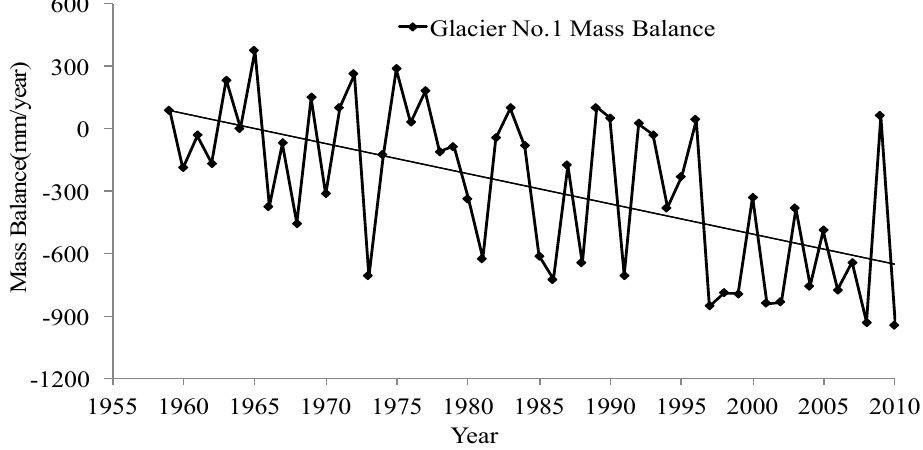
Figure 2. The mass balance of Glacier No. 1 from 1959 to 2010 at the headwaters of the Urumqi River. Table 1. The mass balance of Glacier No. 1 based on the change point results.